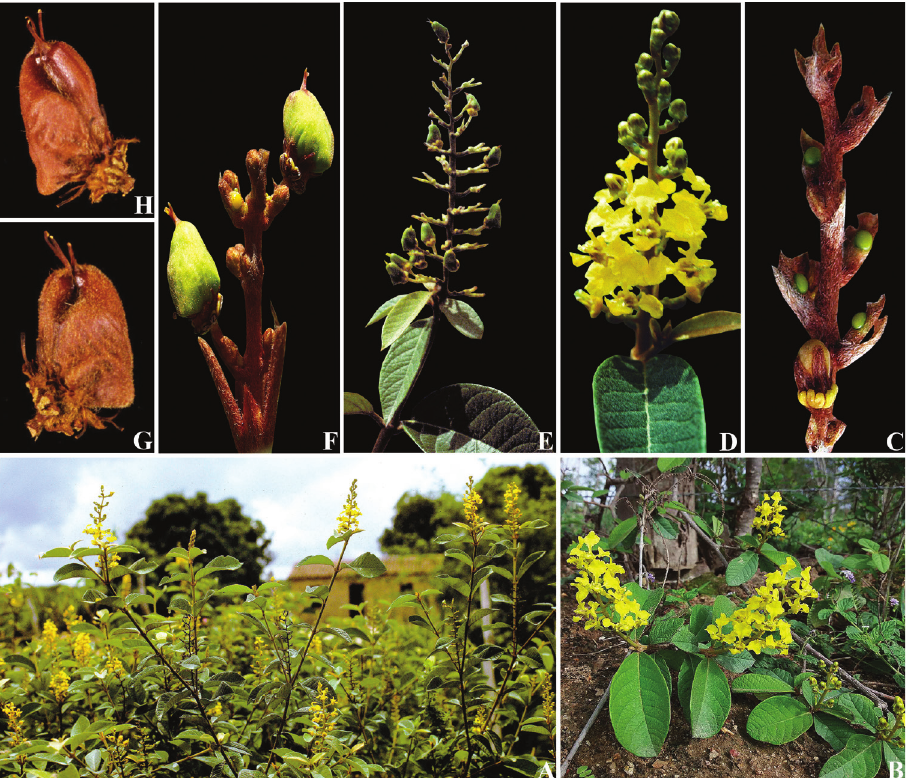
Figure 5. Mcvaughia bahiana . A shrub habit B subshrub habit C inflorescence showing glandular bracts D inflorescence showing flowers in anthesis E inflorescence showing immature and mature fruits F detail of mature fruits G drupe indumentum H glabrescent drupe. A, D–H by W.R. Anderson B–C by I.R.